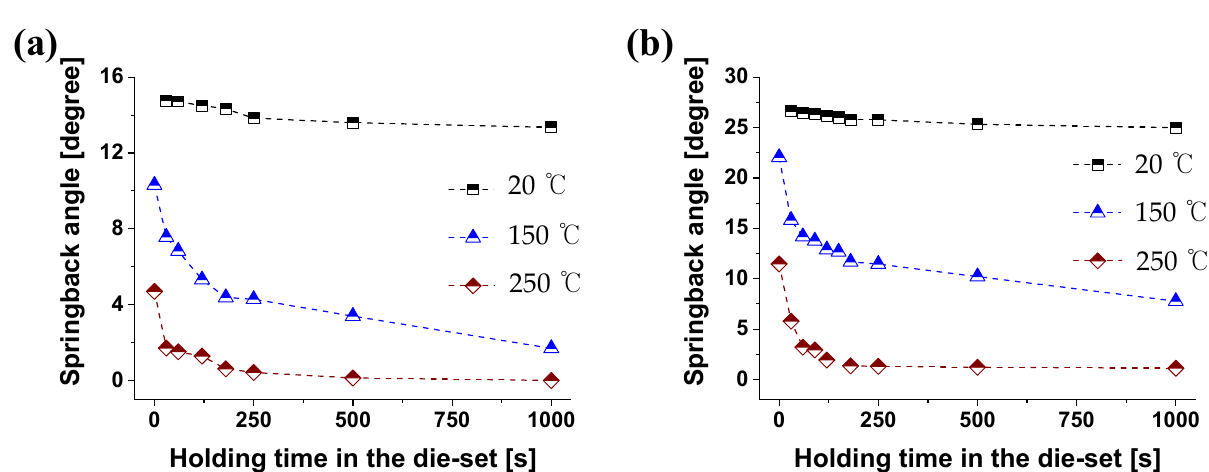
Figure 17. The springback according to holding time in the die set of ( a ) L-bending and ( b ) V-bending with different forming temperatures.